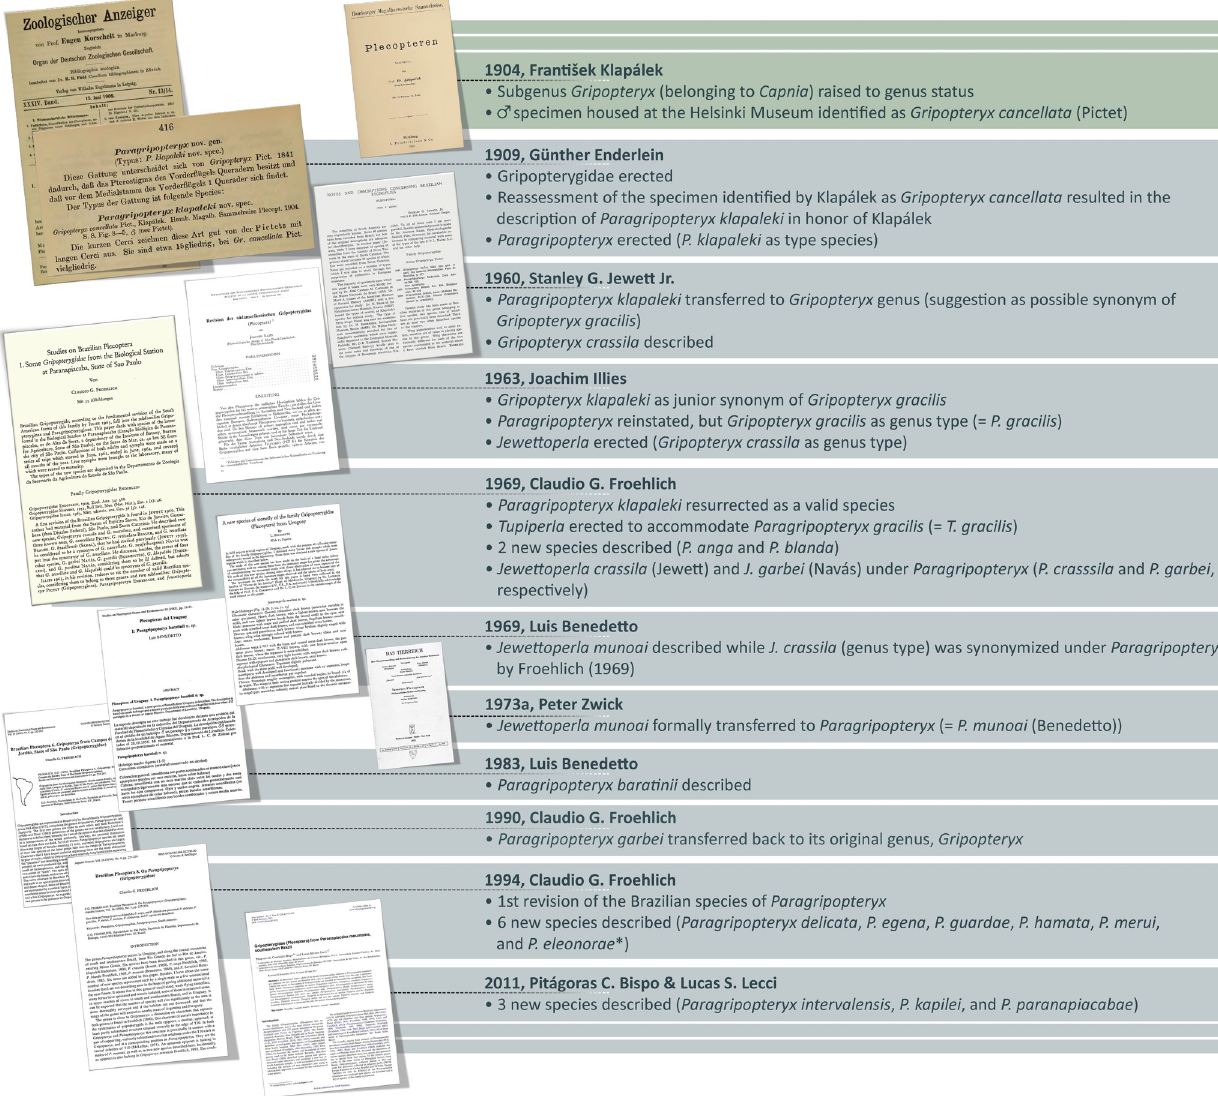
Fig 1. Taxonomic history of Paragripopteryx . � Species combined under the genus Tupiperla by Froehlich [19]. Table 1. Our specimen sampling followed Brazilian laws and were authorized by the SIS- BIO-ICMBio (Biodiversity Authorization and Information System, Chico Mendes Institute for Biodiversity Conservation, numbers 53570–1 and 3363–1). The dataset comprised 30 ter- minal taxa, including 13 Paragripopteryx species, two new species identified as belonging to Paragripopteryx , and 15 outgroup species, among which we can highlight 12 different South American genera and one Australian genus of Gripopterygidae. The outgroup selection was based on McCulloch et al. [6] and Pessacq et al. [23]. Paragripopteryx crassila was analyzed by taking into account the original description pro- vided by Jewett [17] and the photos of the holotype sent to us by Dr. Christopher Grinter from the California Academy of Science (CAS), United States of America. Specimens of P . baratinii were not available for study. Although the material regarding this species was deposited by